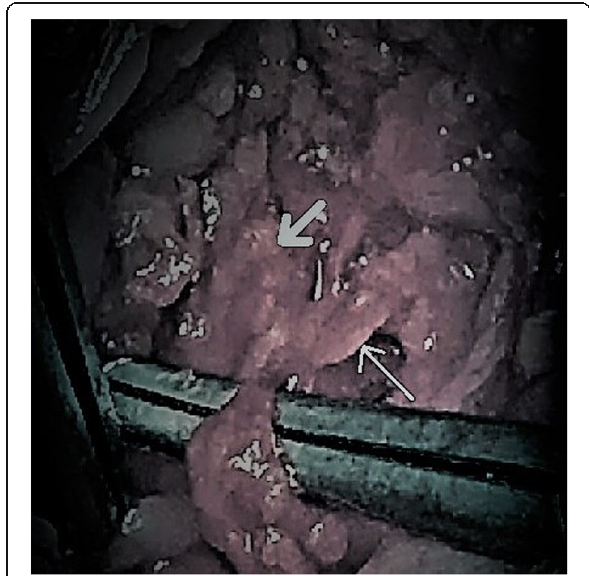
Fig. 1 Intraoperative images showing the proximal part of the nerve (thin arrow) and the neuroma formation (thick